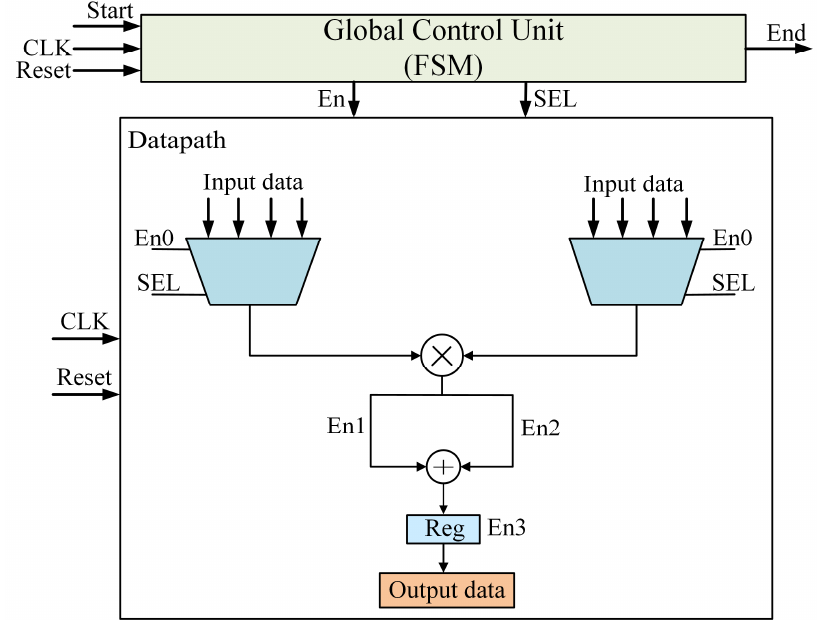
Figure 4. FDFG-based design methodology.